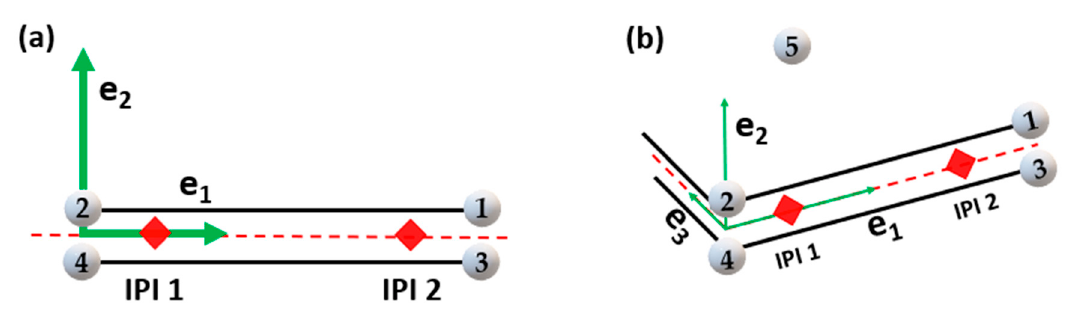
Figure 36. Cohesive element ( a ) plane stress/strain models and ( b ) shell models.